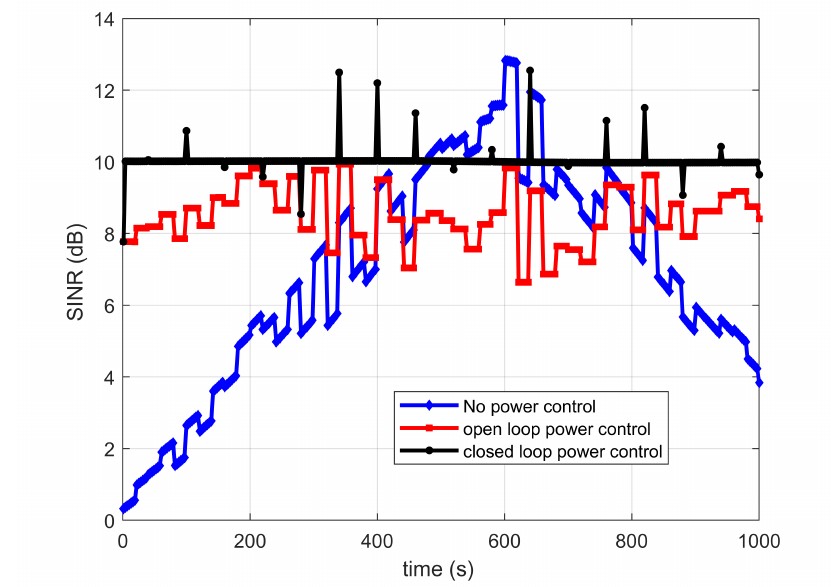
Figure 8. SINR for link between satellite 1 and IoT terminal versus